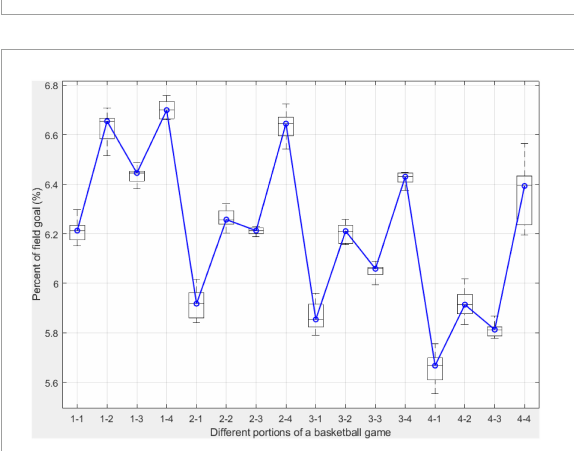
FIGURE5 The percentage of the number of field goals from different 3-min segments in a basketball in the past decade. Each boxplot is comprised of 10 values, each corresponding to one NBA regular season in this study. The blue line connects the median of the